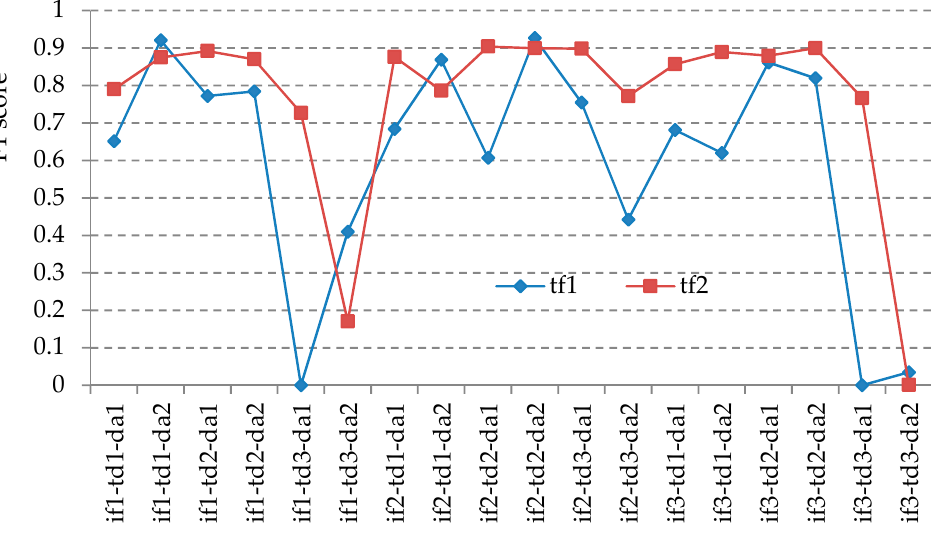
Figure 14. Average F1 scores of 10 test data for 18 groups of models with and without transfer learning.